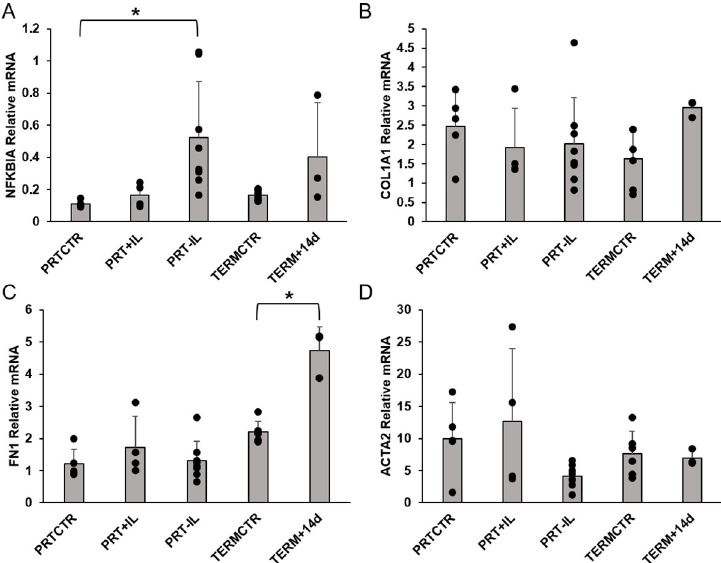
Fig 4. Liver mRNA expression of Pro-fibrotic and Pro-inflammatory genes. Relative mRNA expression of [A] NFKBIA, [B] COL1A1, [C] FN1, and [D] ACTA2 in the livers of infant baboons are shown. � , p < 0.05. PRTCTR: preterm gestational control, n = 5; PRT+IL: preterm with Intralipids, n = 4; PRT-IL: preterm without Intralipids, n = 8; TERMCTR: term gestational control, n = 6; TERM+14d: term gestational control surviving 14 days, n = 3.